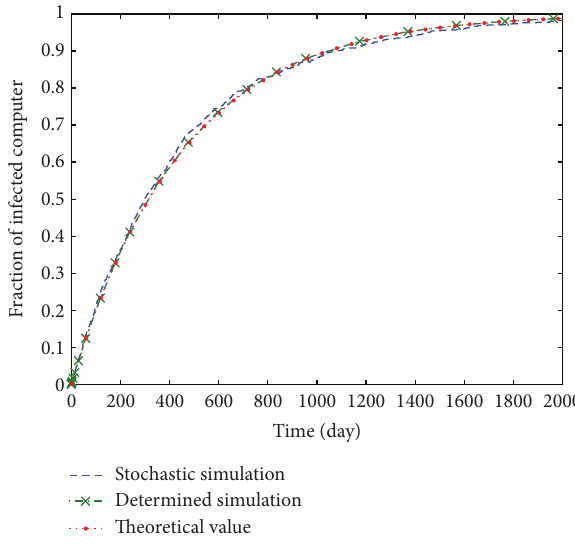
Figure 3: The change figure of proportion of infected computers (𝑡) with time 𝑡 between 𝐼 𝑐 𝑖